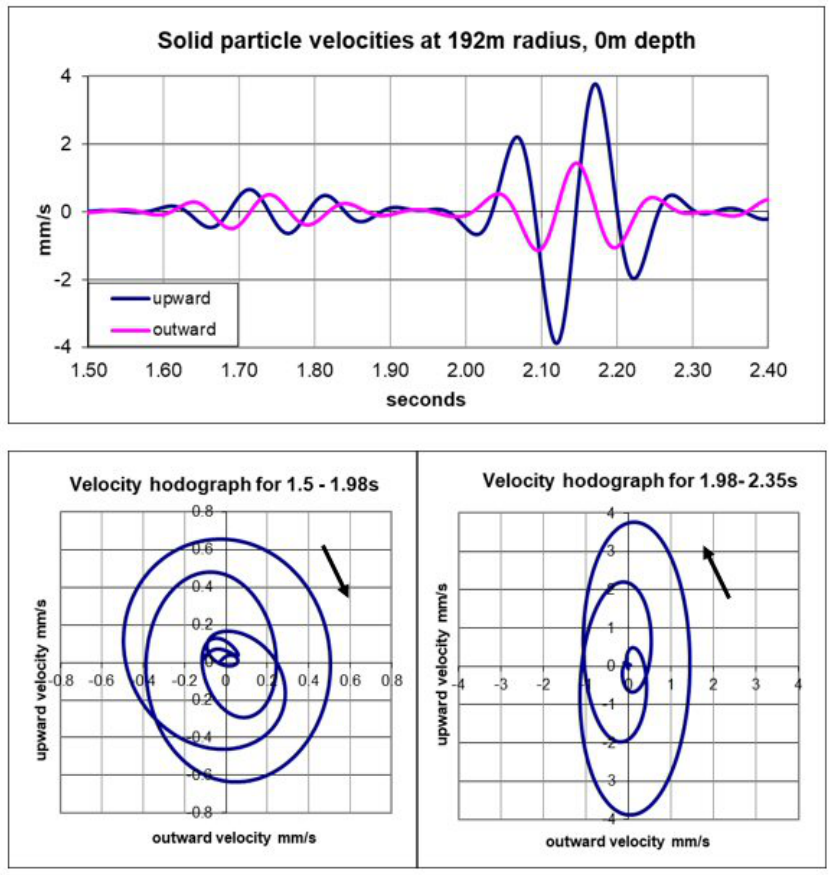
Figure 9. The time series for a solid particle at the interface is shown for the same period of 1.5–2.4 s. Two periods were selected for the hodographs shown below, which differ in both shape and circulation direction.